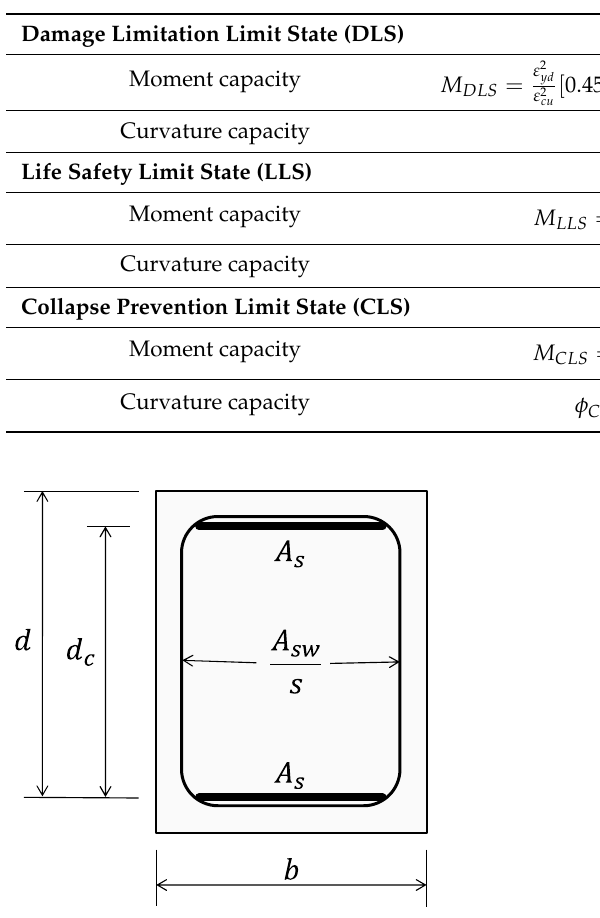
Figure 1. Moment-curvature relationship of a column section with the corresponding Limit State criteria for Damage limitation Limit State (DLS, tension steel yielding), Life safety Limit State (LLS, concrete cover crushing), and Collapse prevention Limit State (CLS, concrete core crushing). Table 1. Flexural failure: equations for resisting moment and curvature at three LSs for the case of rectangular sections with symmetric reinforcement.